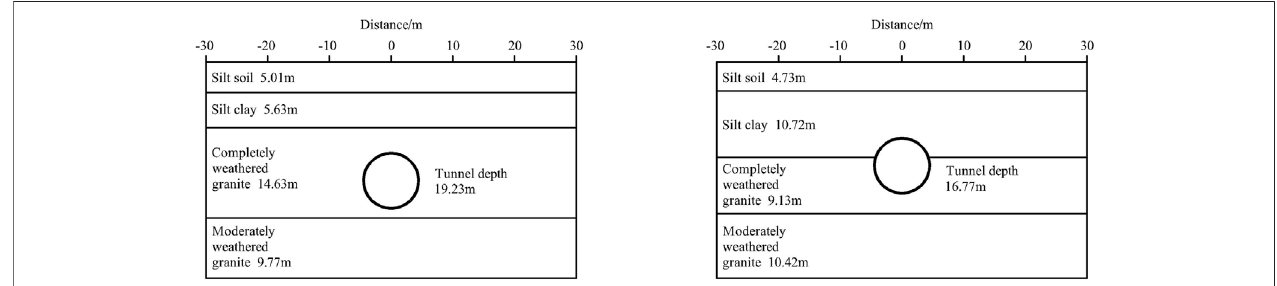
FIGURE 7 | Geological sections.